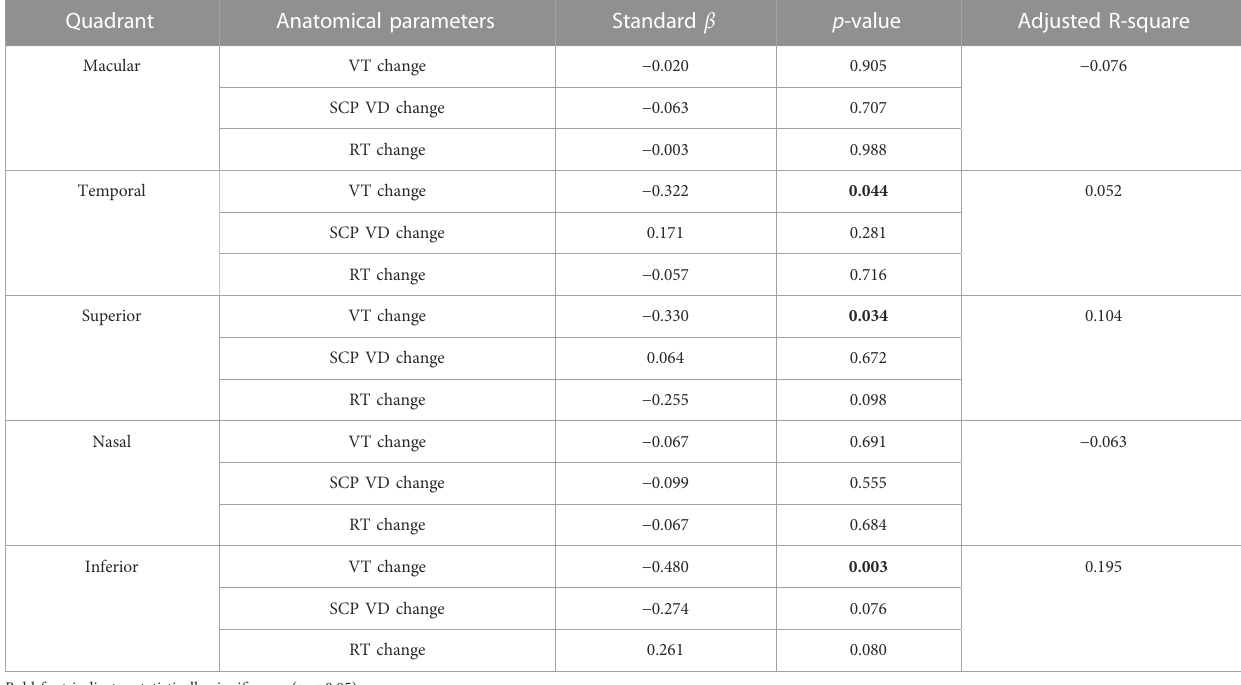
TABLE 5 Correlation between the change in MS and anatomical parameters in different quadrants during the 3-month follow-up after iERM surgery using multivariate linear regression.